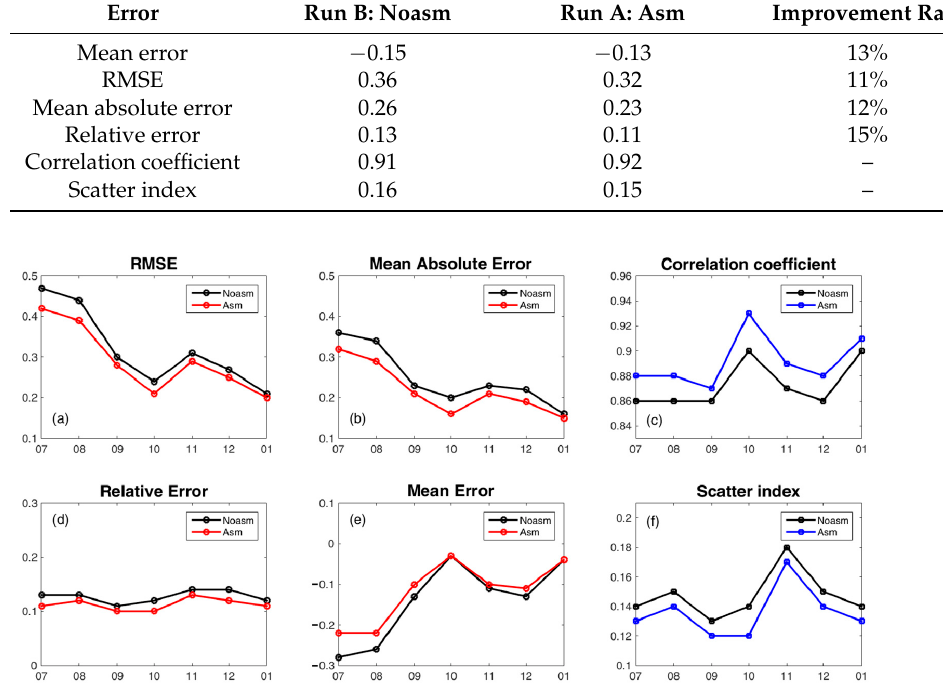
Figure 4. Statistics of model results against observations from CFOSAT satellite computed every month during the period from 1 July 2020 to 31 January 2021. ( a ) Root mean square error; ( b ) Mean absolute error; ( c ) Correlation coefficient; ( d ) Relative error; ( e ) Mean error; ( f ) Scatter index.